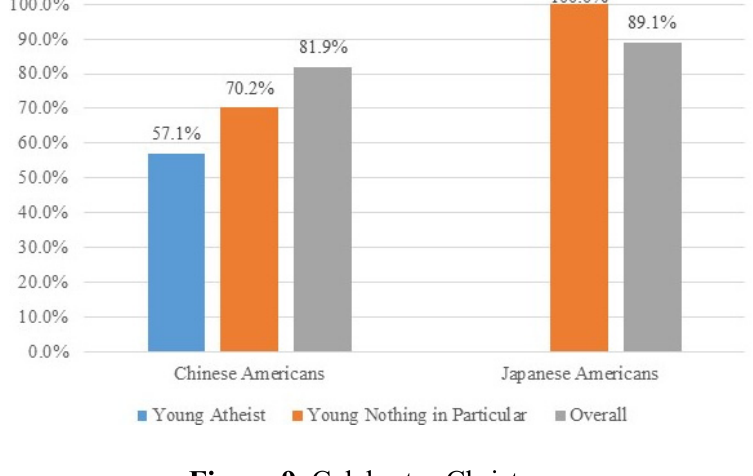
Figure 9. Celebrates